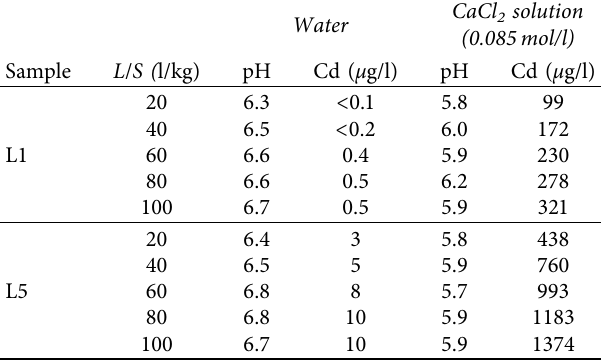
L/S � liquid/solid